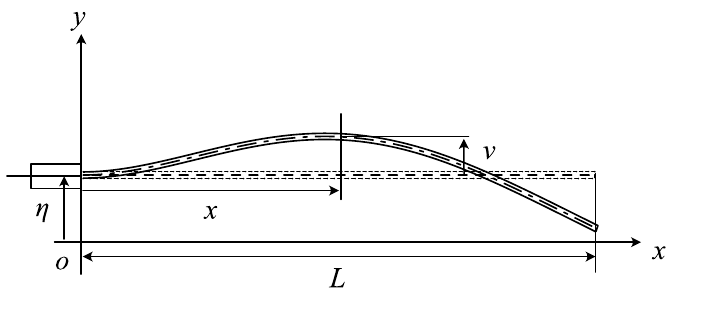
Figure 1. Analytical model of cantilever subject to the displacement excitation; η is the displacement excitation by actuator to produce the self-excited